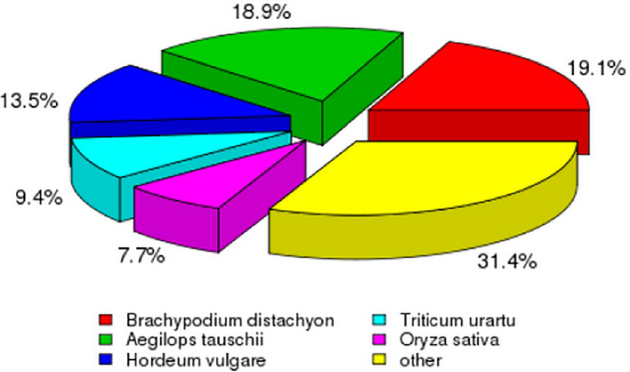
Fig 4. Summary and taxonomic source of BLASTx matches for Kentucky bluegrass unigenes. Percentage of unique best BLASTx matches of unigenes grouped by genus.